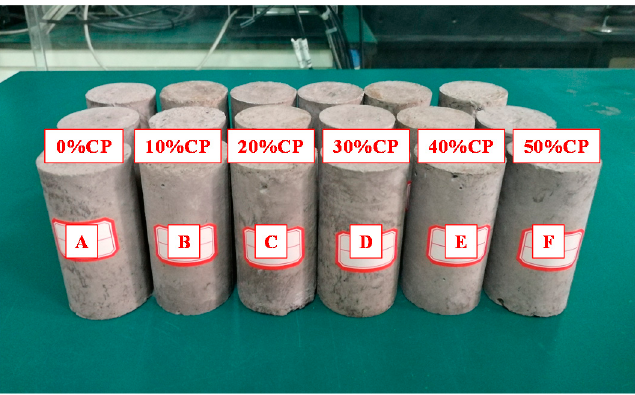
Figure 3. CGFB samples.